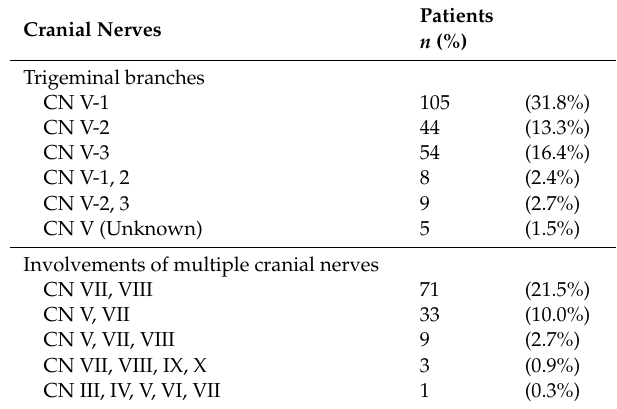
Table 2. The involvements of trigeminal branches and multiple cranial nerves in 330 patients with herpes zoster infection.